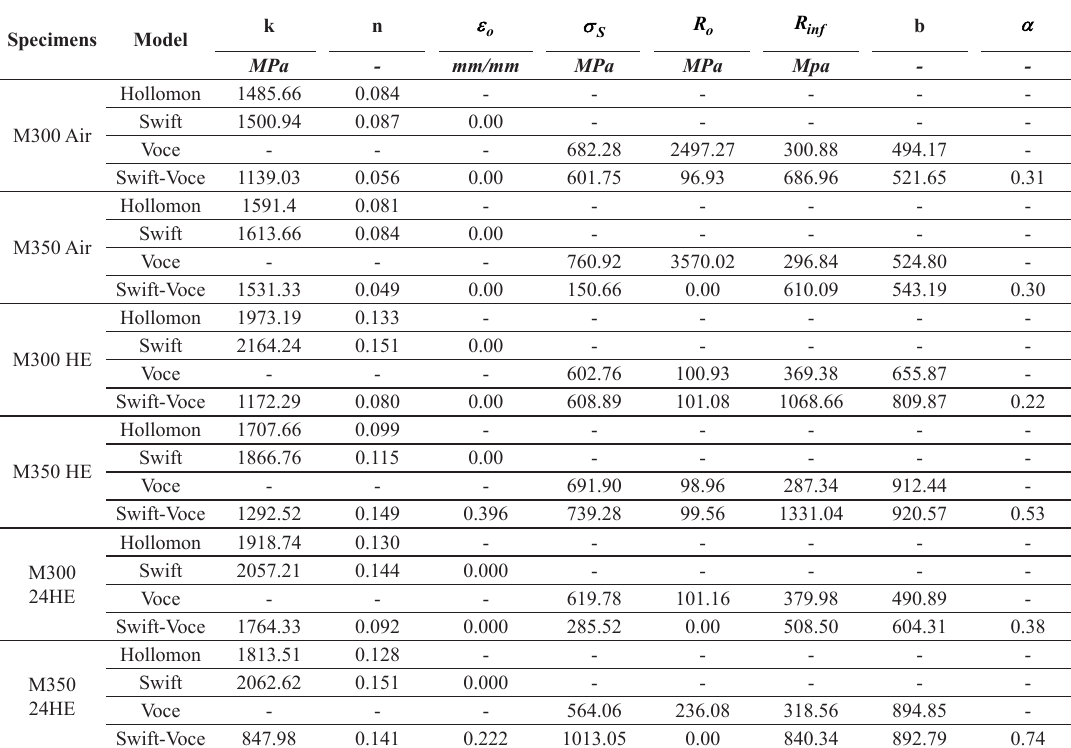
Table 4. Best fitting parameters of Hollomon, Swift, Voce and coupled Swift-Voce models for M300 and M350 in air, HE and 24HE condition. Specimens Model